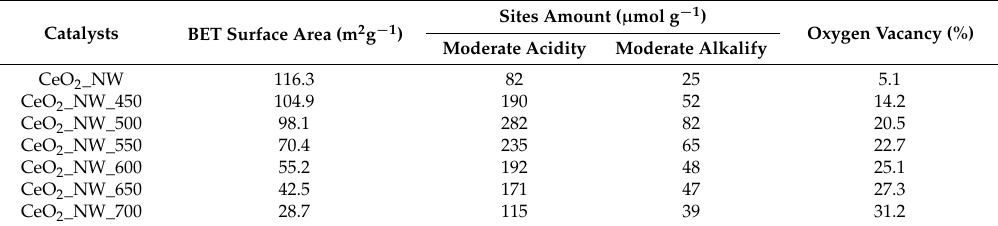
Table 1. Textural data of as-prepared catalysts basing on BET, XRD, and XPS investigation.